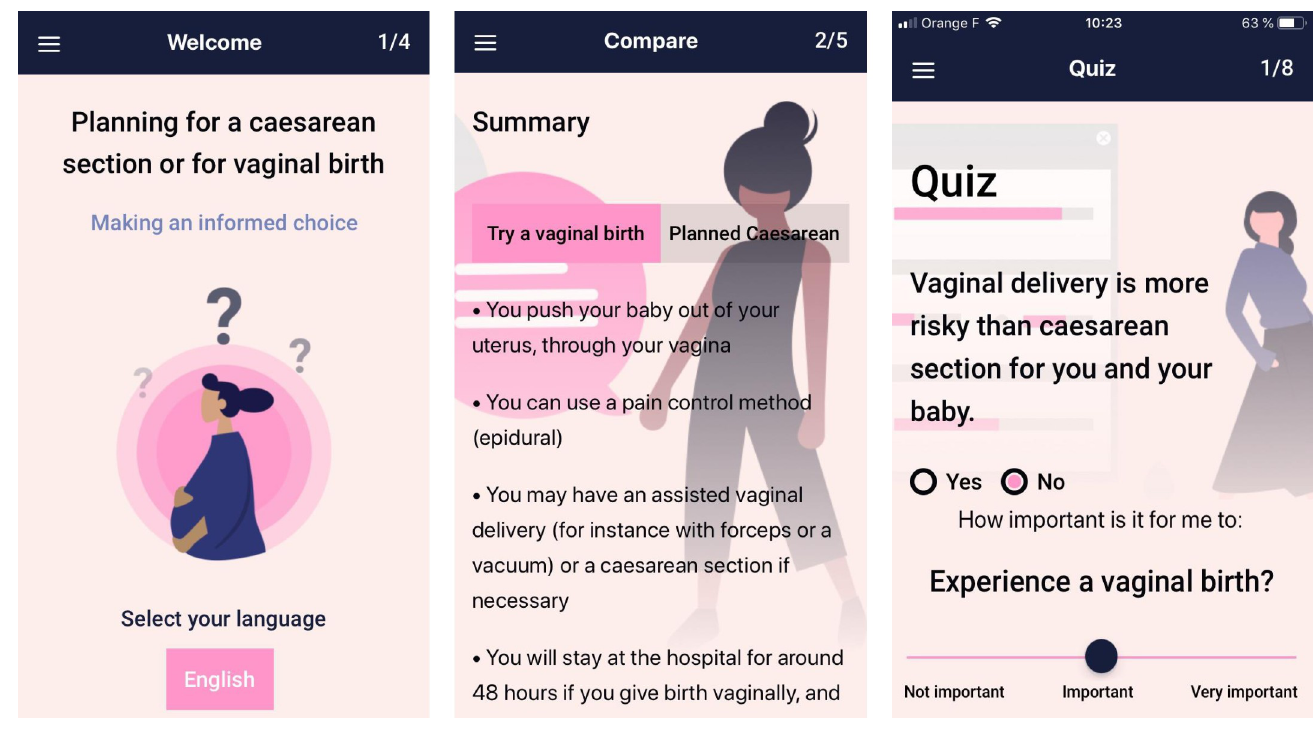
Fig 1. Decision-analysis tool application for